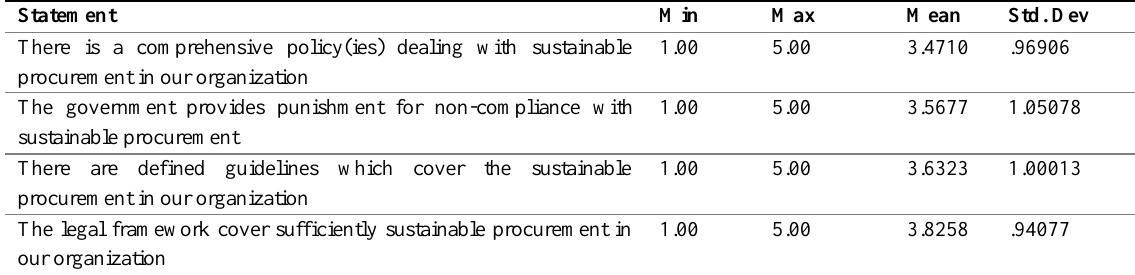
Table 4: Effect of Legal Framework on Sustainable Procurement